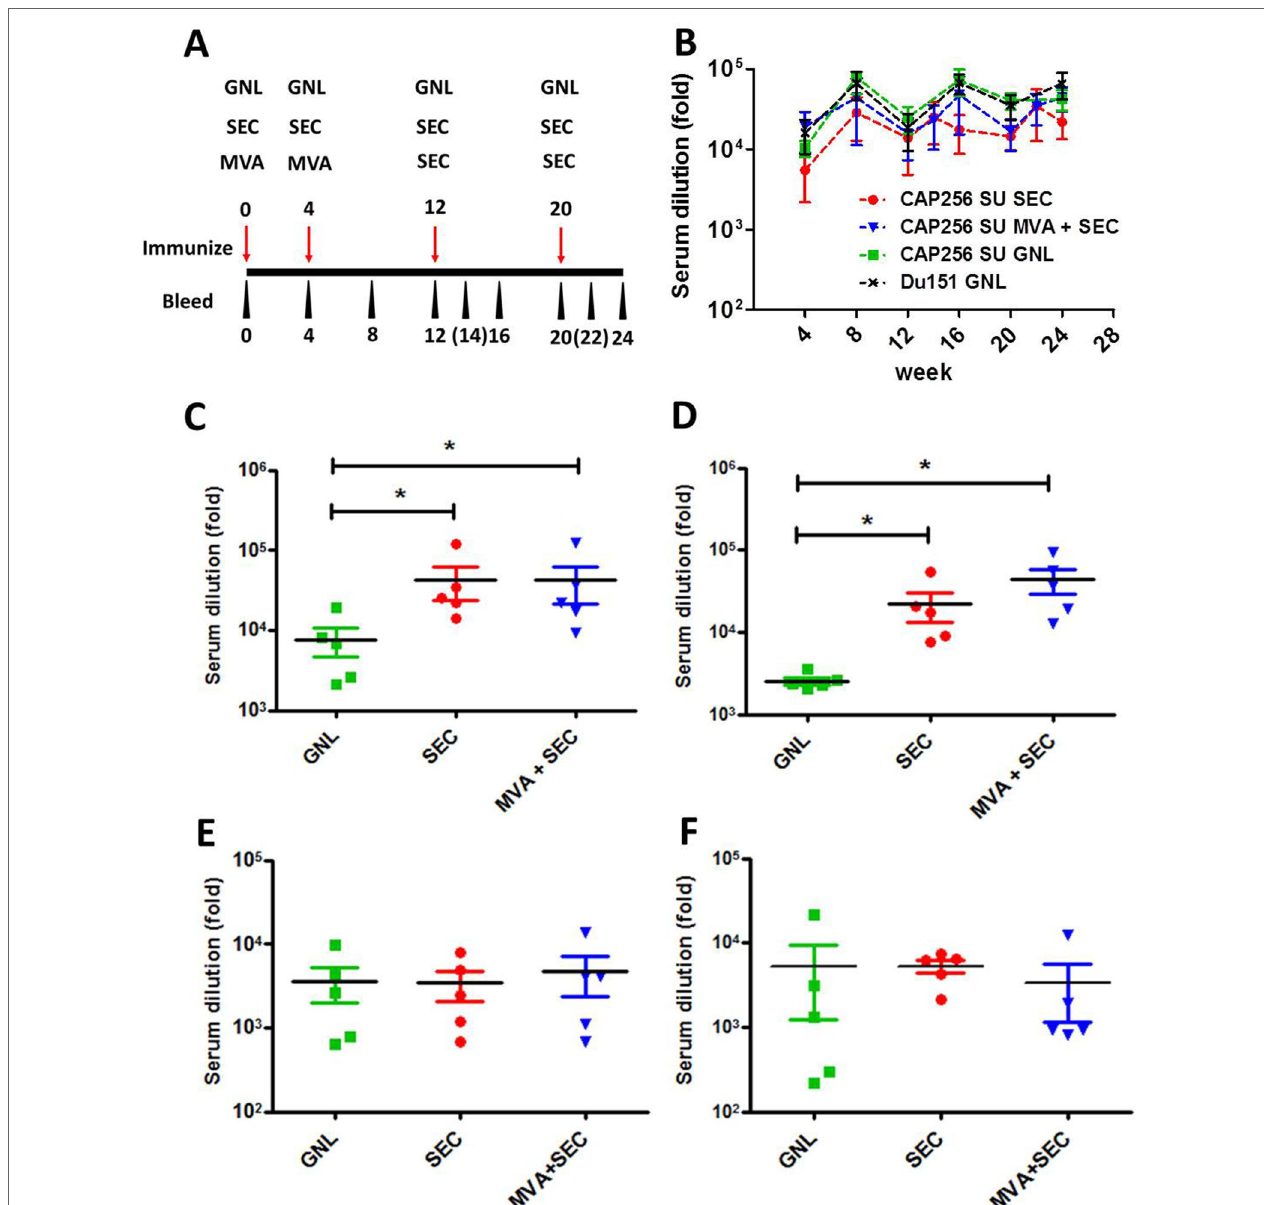
FIgUrE 2 | Immunogenicity of the different vaccination regimens in rabbits. (A) Immunization schematic indicating the timing of immunizations and bleeds. Time points in brackets indicate blood draws which were taken for the group immunized with the SEC-purified protein only. (B) Serum binding antibodies elicited over the course of the immunization regimen to the matched antigen, purified from mammalian cells, that was used to immunize animals. The levels of serum binding antibody titres elicited by the different vaccination regimens of CAP256 SU Env were compared after the 3 rd (C) and 4 th (D) immunizations. Similarly, autologous V1V2 binding antibodies were quantified after the 3 rd (E) and 4 th (F) inoculation. Statistical comparisons between groups were performed using a two-tailed, unpaired Mann-Whitney test (*p < 0.05). The levels of binding antibodies are indicated as a fold-dilution derived from the fitted four-point linear regression curve using a threshold of the minimum + standard error of the minimum for each time